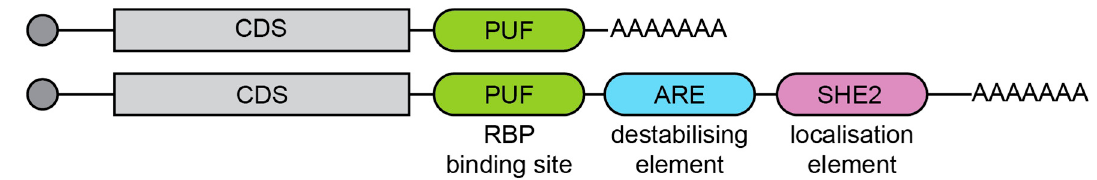
Figure 1. Cis -regulatory elements play a role in 3 ′ UTR isoform-specific translation. Alternative polyadenylation allows for the exclusion (top) or inclusion (bottom) of various cis -regulatory elements within the 3 ′ UTR. In yeast, these may include destabilising sequences such as A-rich elements (AREs), localisation elements such as She2p binding sites, and binding sites for trans -acting factors such as Pumilio family (Puf) proteins. Some cis -elements may be present in several isoforms. The sum effect of these different elements determines the overall stability, localisation, and translational efficiency of individual transcripts.